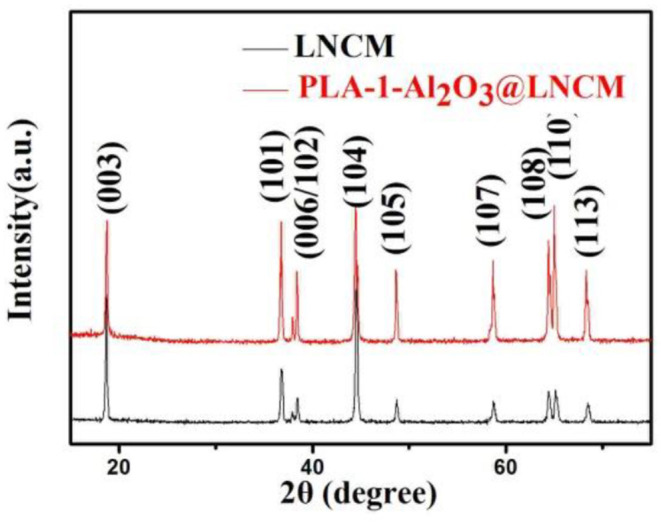
Powder X-ray diffraction patterns of LNCM and PLA-1-Al2O3@LNCM.